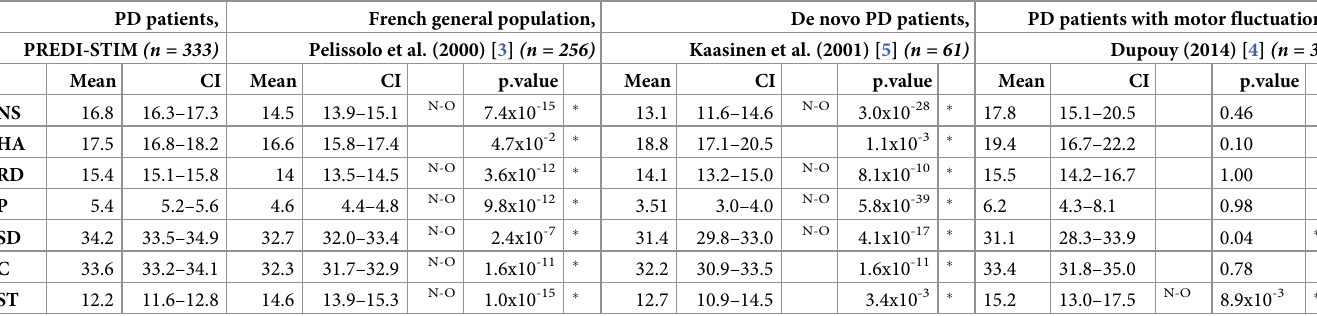
One-sample (for Pelissolo and Kaasinen studies) and two-sample (for Dupouy study) Wilcoxon tests: � p.value < 0.05 –CI = Confidence Interval at a confidence level of Directedness; C = Cooperativeness; ST = Self-Transcendence. lower scores in the ST dimension than the other population of PD patients with motor fluctuations [4] (Table